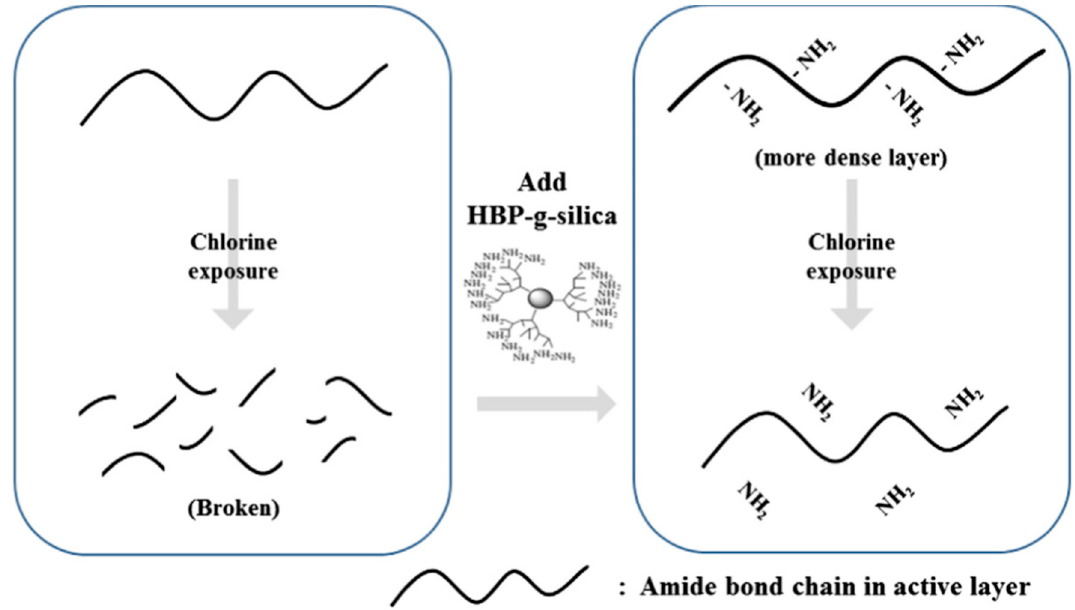
Figure 4. Protection sequence against chlorine attack, reproduced with permission from Kim et al. [85], with copyright permission from © 2013 Elsevier.